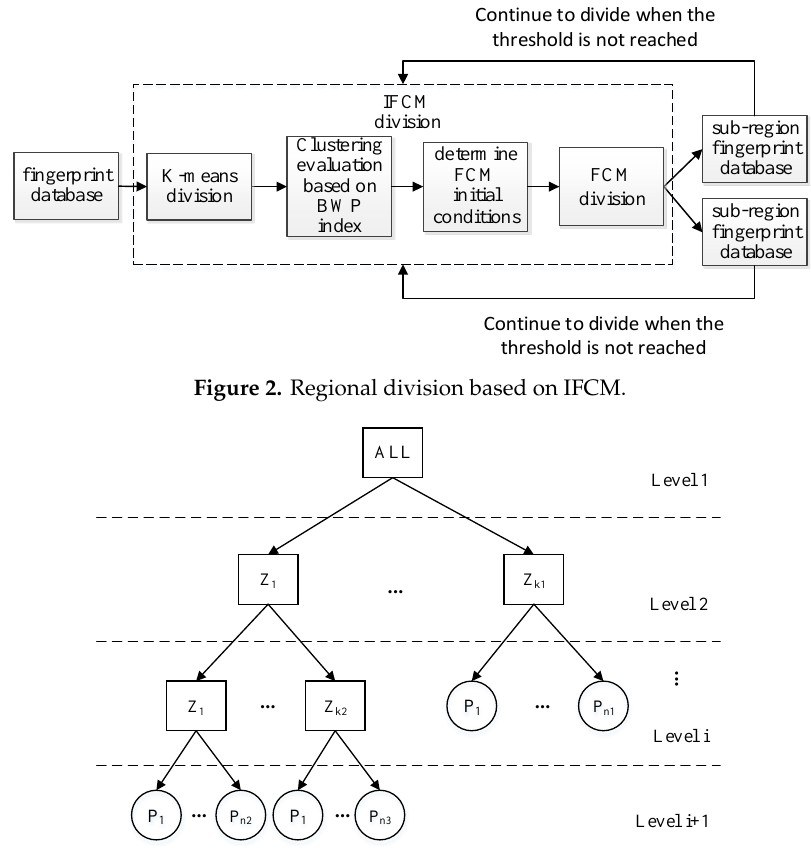
Figure 3. Structure of regional division.